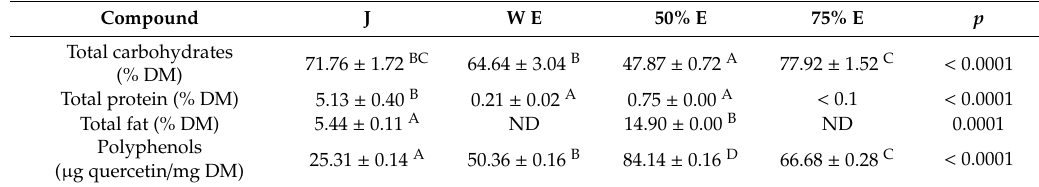
1 Data are expressed as mean ± standard error of the mean. Statistically significant e ff ect: values of one parameter without common superscript (A,B,C,D) are significantly di ff erent ( p < 0.01). n = 3 (total carbohydrates and polyphenols), n = 6 (total protein), n = 2 (total fat). ND—not determined, DM—dry